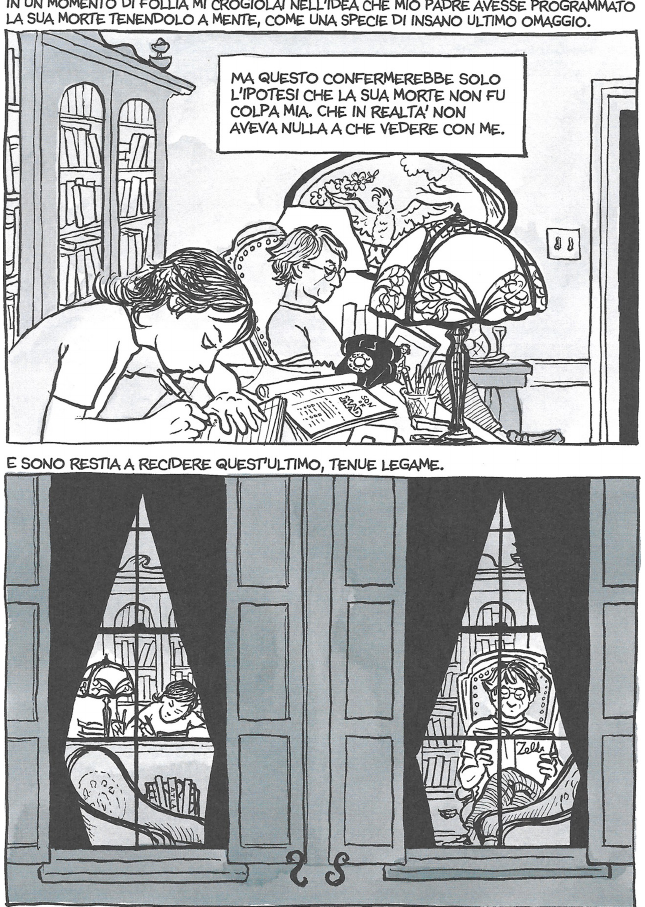
portrays father and daughter together in the library which, seen from the outside, seems to be two separate rooms (Bechdel, 2007, p.